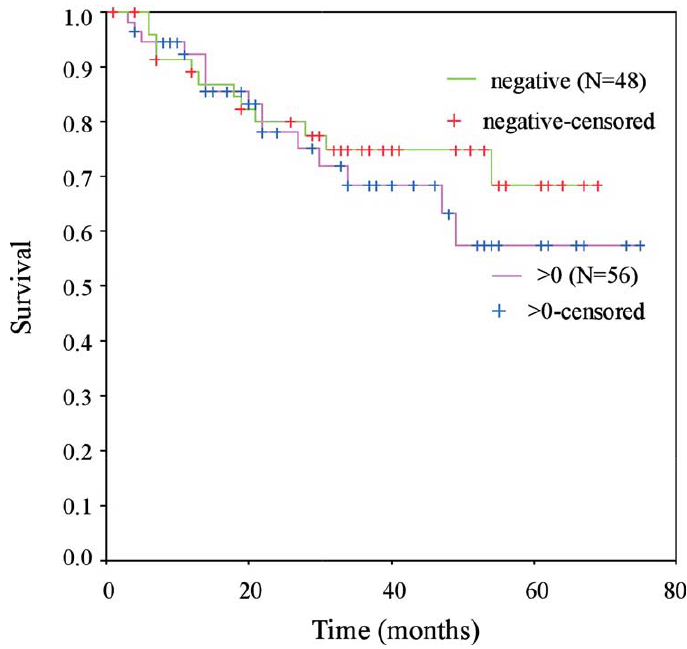
Fig. 4. Correlating HOXA5 expression with survival